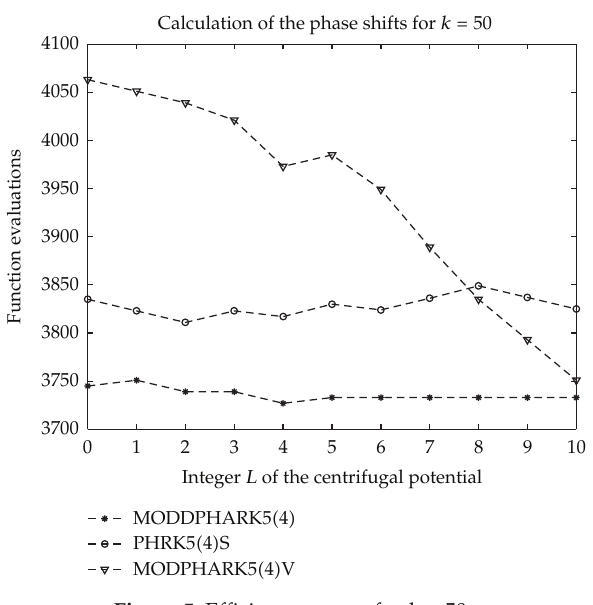
Figure 5: E ffi ciency curves for k (cid:7) 50.